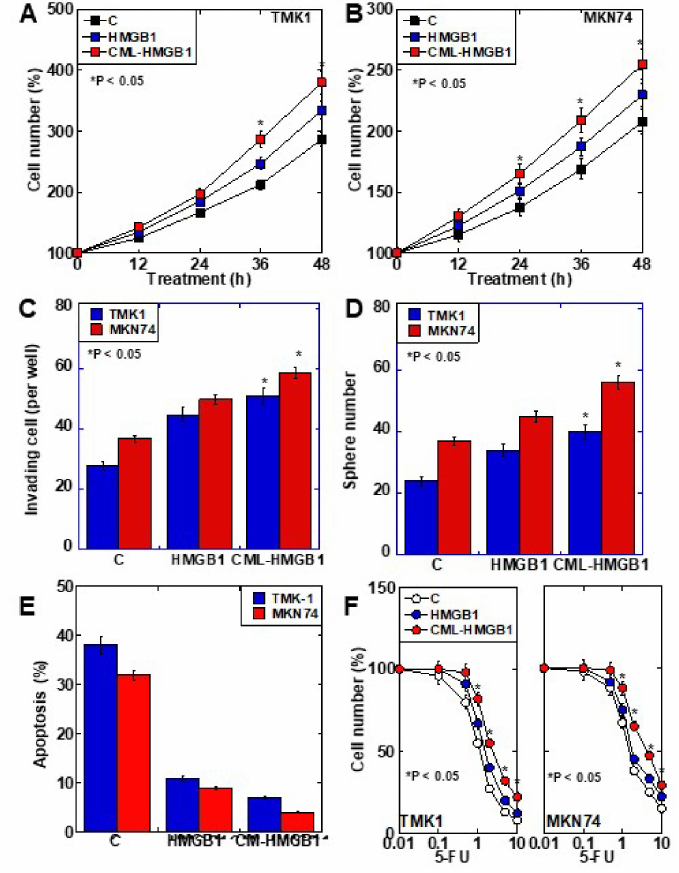
Figure 3. Effect of CML-HMGB1 on malignant properties of TMK-1 and MKN74 gastric cancer cells. ( A , B ) Effect of CML-HMGB1 (10 µ g/mL) and HMGB1 (10 µ g/mL) on cell proliferation. ( C , D ) Effect of CML-HMGB1 and HMGB1 on cell invasion by in vitro invasion assay and stemness by sphere formation. ( E ) Effect of CML-HMGB1 and HMGB1 on protection from apoptosis. Cells were untreated or treated with thapsigargin (5 µ M) for 48 h with CML-HMGB1 or HMGB1. ( F ) Effect of CML-HMGB1 and HMGB1 on sensitivity to 5-FU. Cells were untreated or treated with 5-FU for 48 h with CML-HMGB1 or HMGB1 ( C ). Error bar and standard deviation calculated by ordinary analysis of variance from three independent experiments. CML, N ε -( Carboxymethyl ) lysine ; HMGB1, high-mobility group box-1; C, untreated control; 5-FU, 5-fluorouracil. * P <